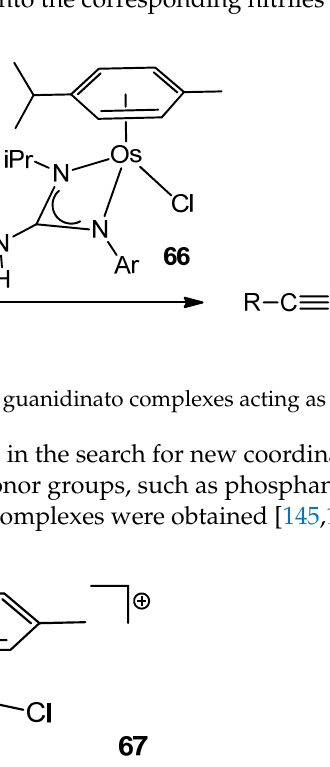
Figure 38. Ruthenium (IV) guanidinato complex [RuCl{ κ 2 -C(NR)(NiPr)NHiPr}( η 3 : η 3 -C 10 H 16 )].